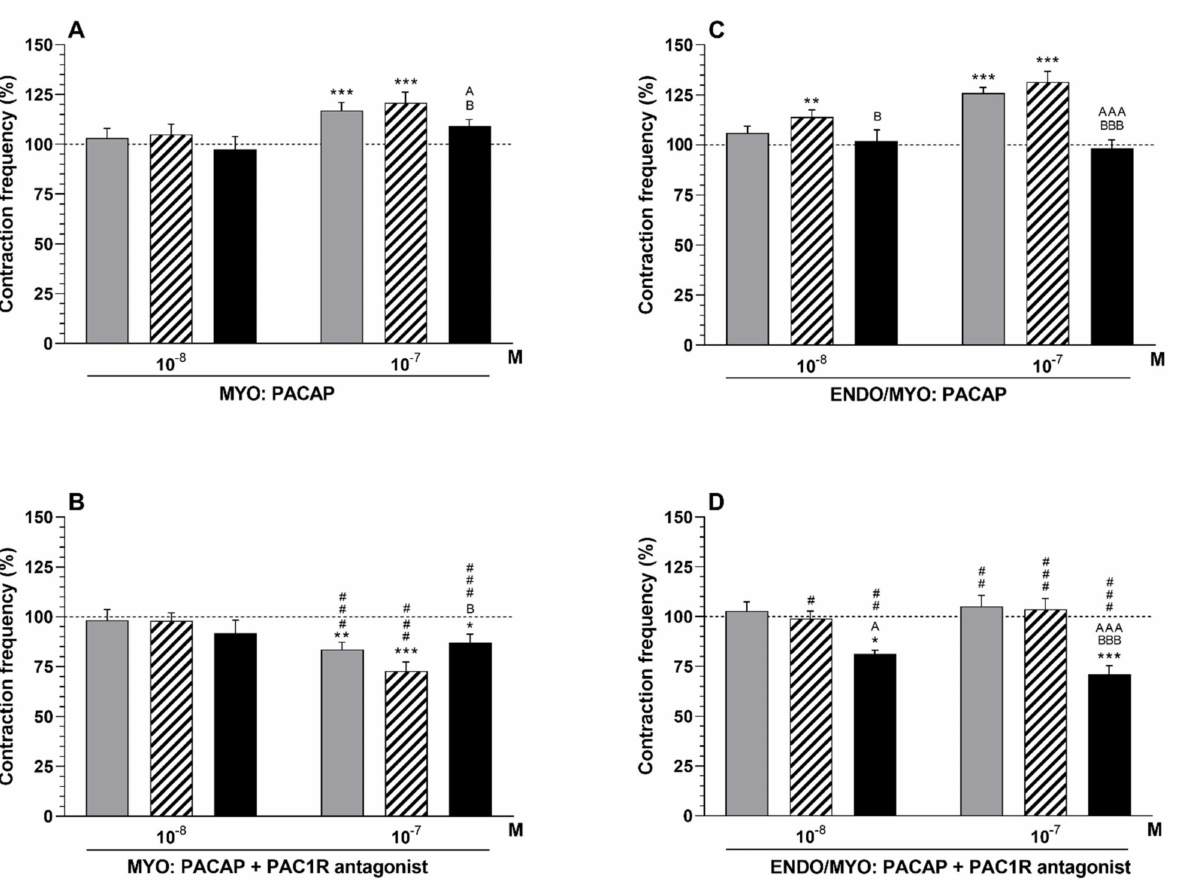
Figure 5. Influence of pituitary adenylate cyclase-activating peptide (PACAP) alone ( A , C ) and PACAP receptor (PAC1R) antagonist with PACAP ( B , D ) on the contractile frequency in the myometria ( A , B ) and endometrium/myometrium ( C , D ) strips of gilts from the CON (grey bars), SAL (hatched bars) and E. coli (black bars) groups. Results were calculated for five gilts in each group. The actions of the antagonist (a dose of 10 − 6 M) and particular PACAP doses are depicted as the percentage (mean ± SEM) change from the basal (pre-treatment period) frequency, taken as 100% (horizontal lines). * p < 0.05, ** p < 0.01, *** p < 0.001 compared to the basal value in each group; A p < 0.05, AAA p < 0.001 compared between the CON and E. coli groups for the same treatment; B p < 0.05, BBB p < 0.001 compared between the SAL and E. coli groups for the same treatment; # p < 0.05, ## p < 0.01, ### p < 0.001 compared between the antagonist with PACAP action versus PACAP action alone for the same group/tissue/PACAP